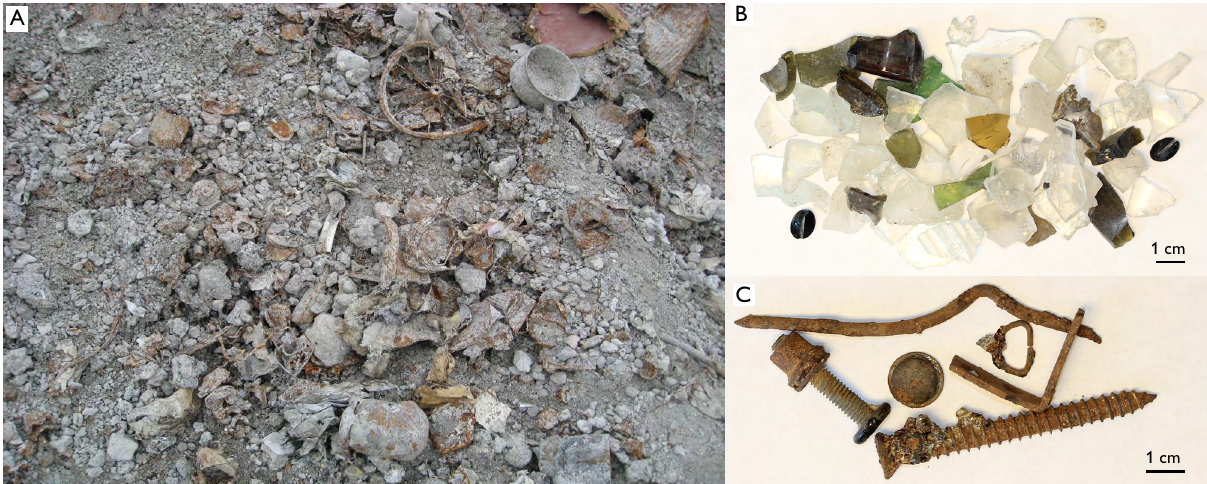
Fig. 1: Example waste from Amager Bakke waste-to-energy plant. A : Unprocessed incinerator bottom ash (reproduced from Clausen et al . 2019). B : Non-de- formed glass fragments (sample number 567662 A; Clausen et al . 2019). C : Magnetic, non-deformed metal (sample number 567662 A; Clausen et al .